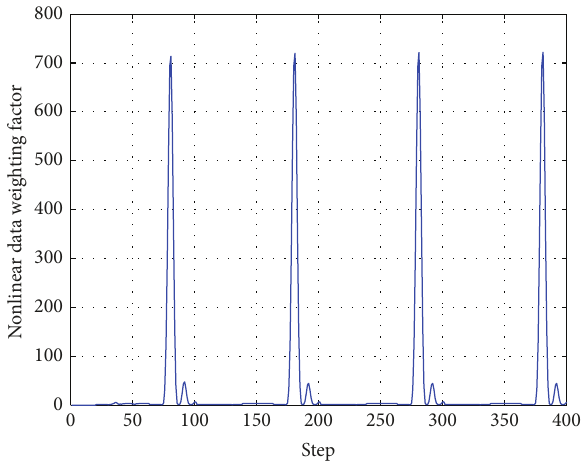
Figure 1: The profile of nonlinear data-weighting factor 𝛼(𝑡) .